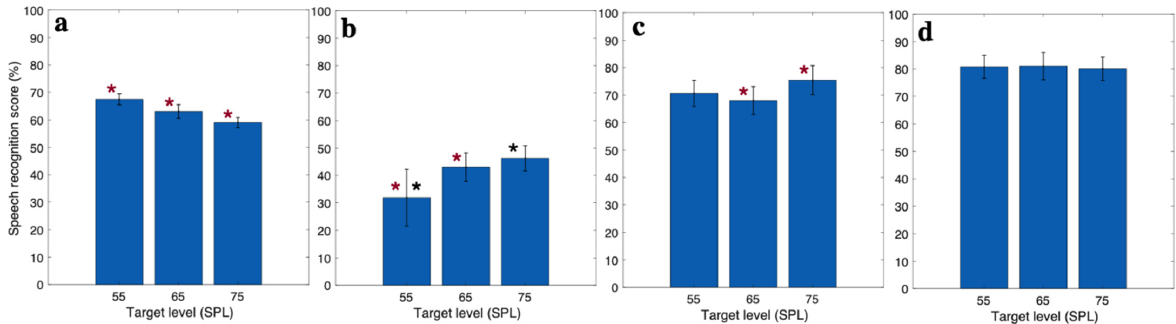
Figure 3. Speech recognition score for ( a ) EH, ( b ) AH, ( c ) EAH CI listeners, and ( d ) NH listeners, (In each plot, asterisks (*) with the same color show the significant difference between the corresponding scores).